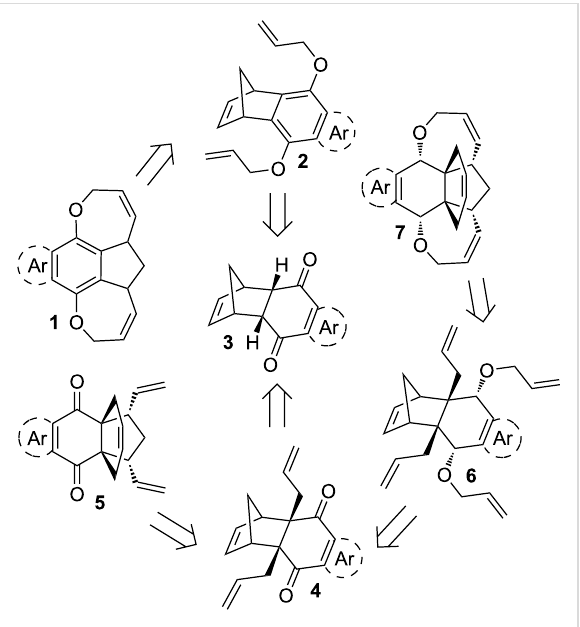
Figure 1: RRM route to propellane derivatives and